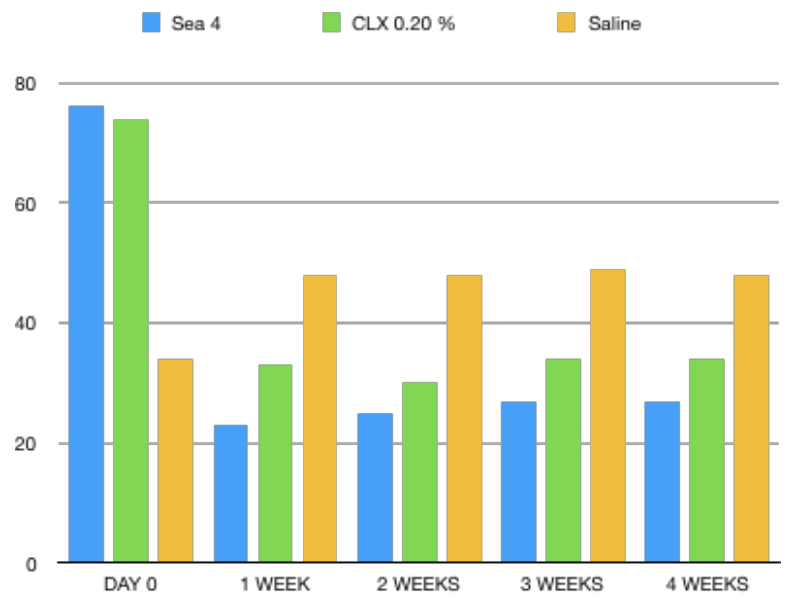
Figure 4. Gingival Index frequency. Seawater was effective in gingival index reduction compared with Chlorhexidine 0.20% and saline.